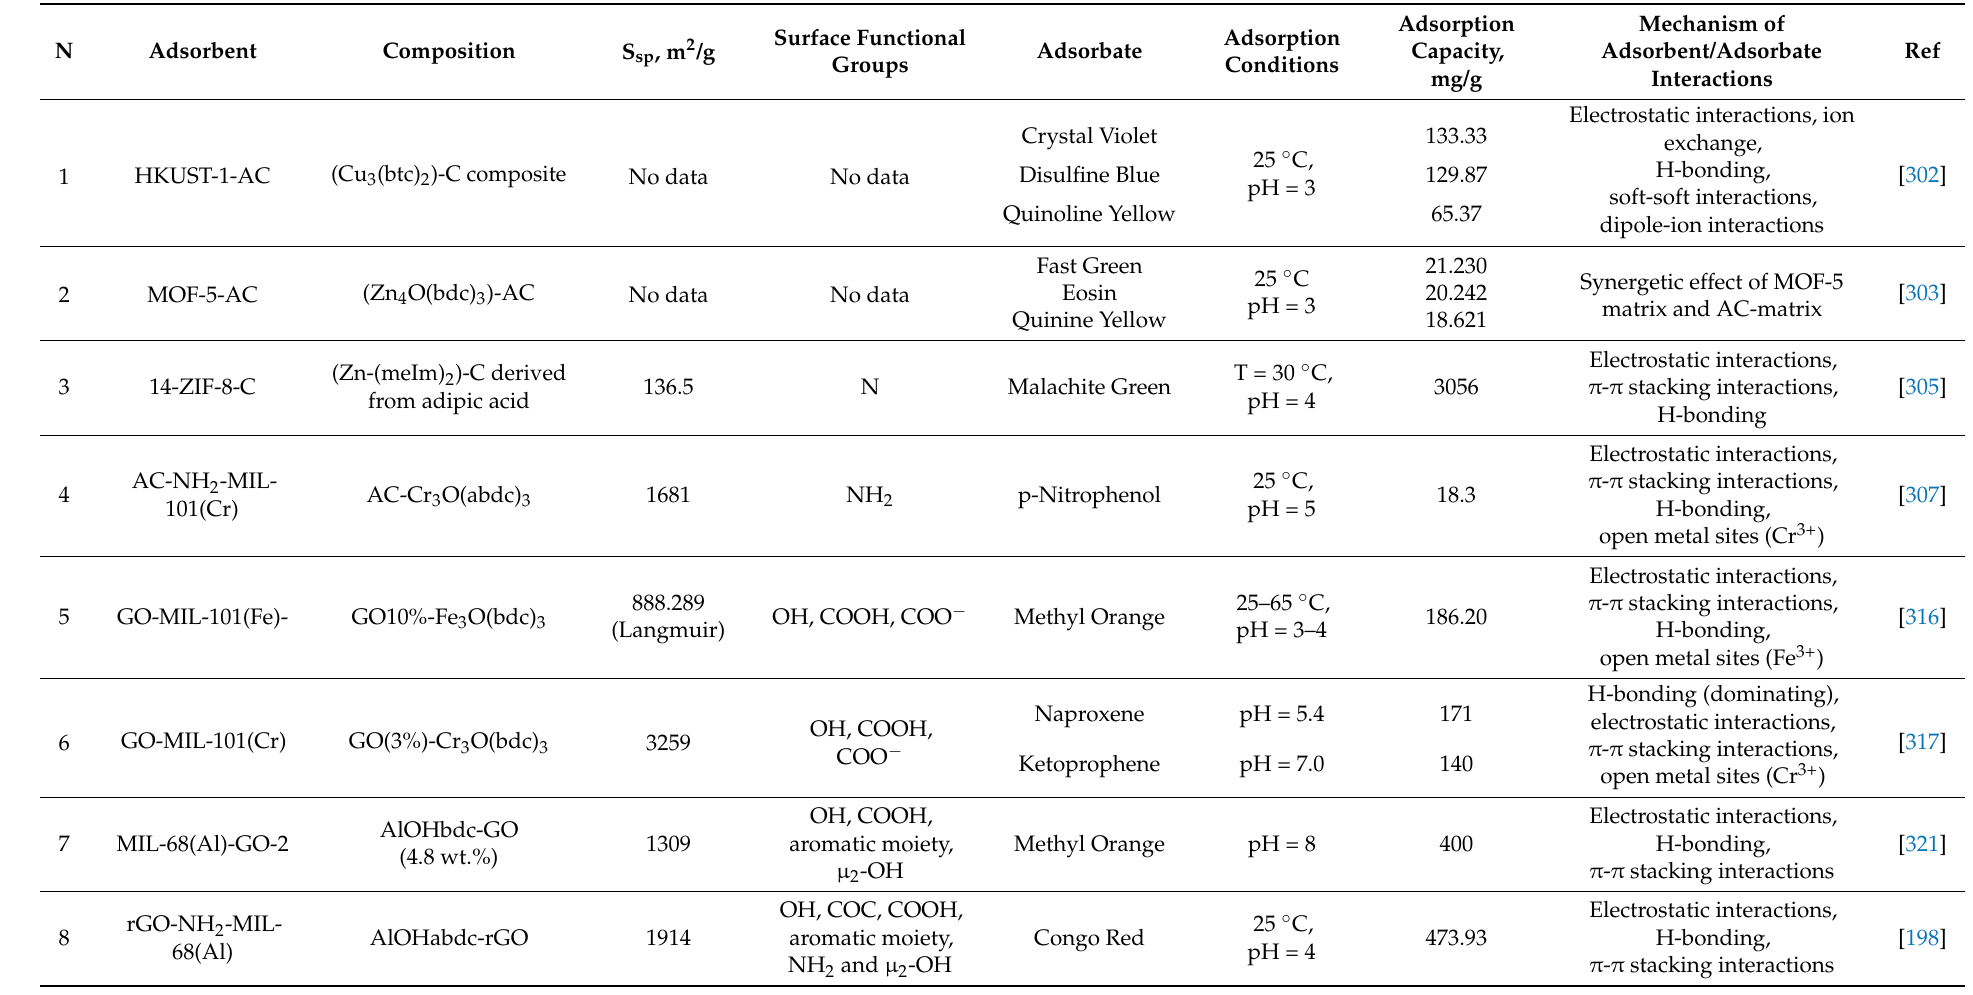
Table 3. Surface characteristics, adsorption capacity and mechanisms for the adsorption of organic pollutants using MOF-Carbon